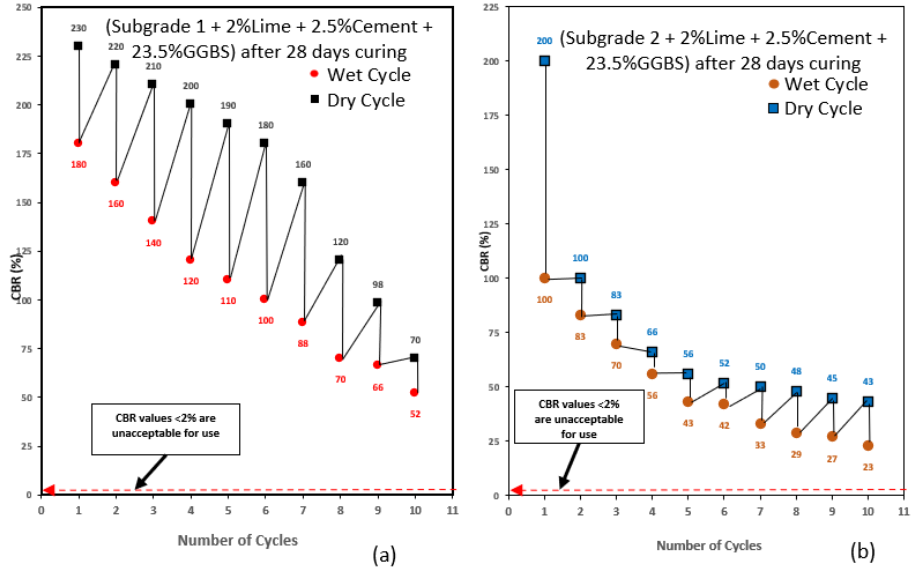
Figure 4. ( a ) Wetting – drying cycle results for subgrade 1 composed of GGBS after 28 days of curing. ( b ) Wetting – drying cycle results for subgrade 2 composed of GGBS after 28 days of curing.